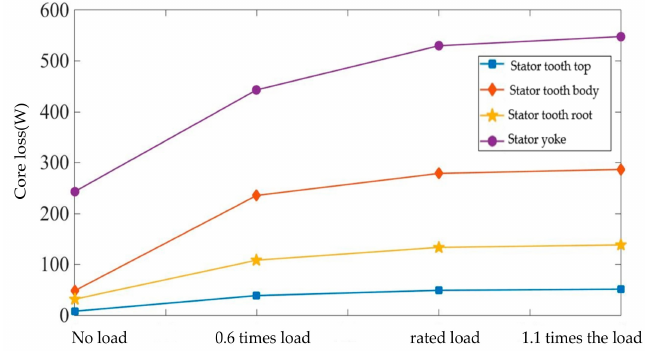
Figure 11. Stator iron core loss changes in each region under four types of operating